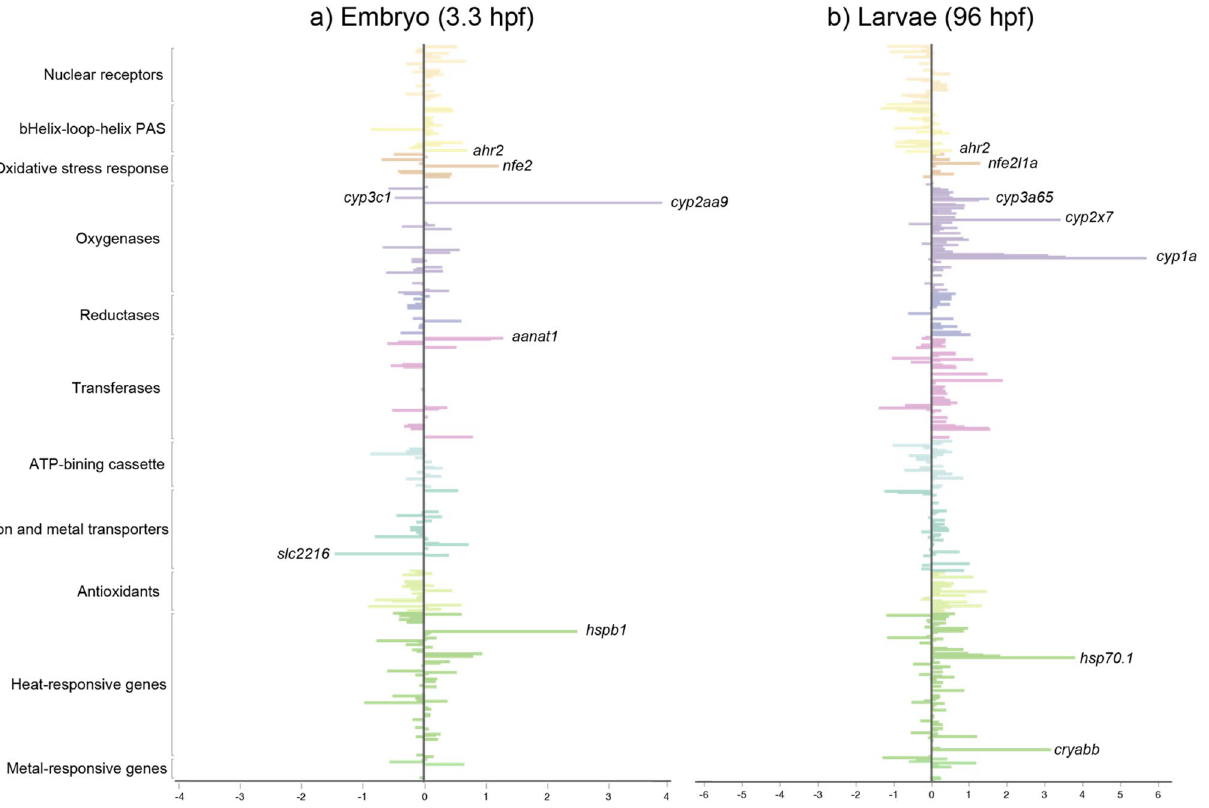
Figure 4. Transcriptional responses on chemical defensome genes in ( a ) zebrafish embryo (3.3 h post fertilization (hpf)) and ( b ) zebrafish larvae (96 hpf) following exposure to benzo(a)pyrene. The transcription is shown as log2 fold change between exposed and control group at each timepoint. The genes are grouped into their functional categories in the chemical defensome and the name of some genes are indicated for